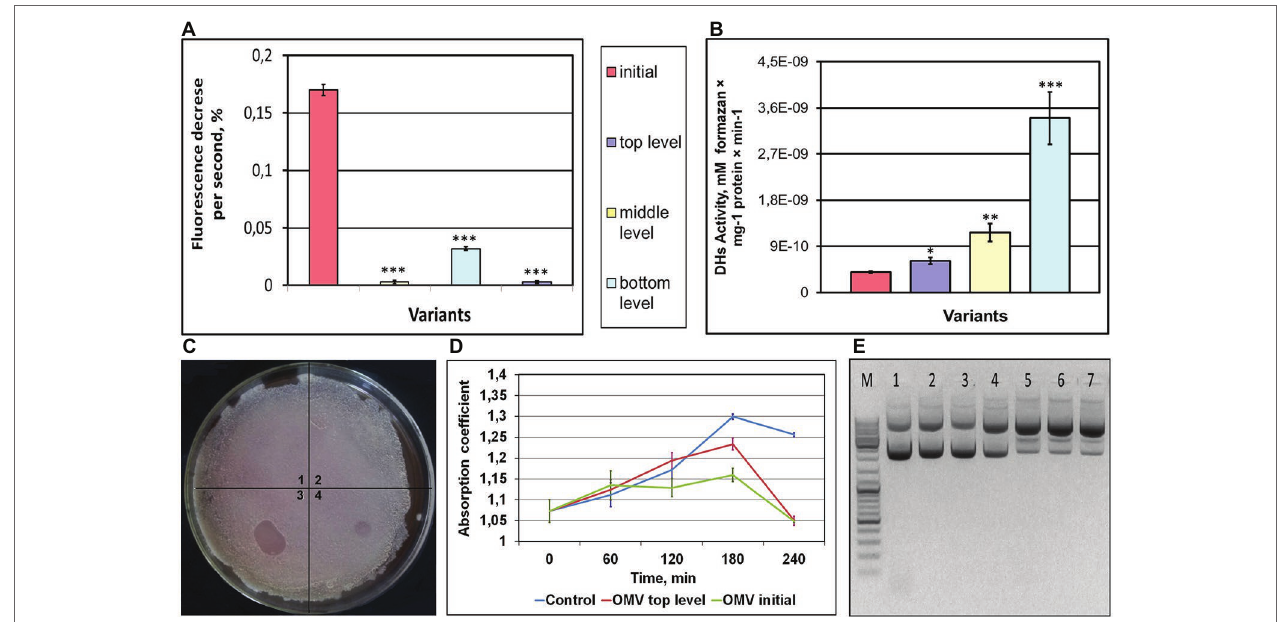
FIGURE 3 | Functionality of OMVs of K. intermedius , isolated from post-flight KMCs (A,B,D,E) and extracellular vesicles (EVs) isolated from the post-flight KMC samples (C) . (A) OMVs acidification measured using a pH-sensitive fluorescent dye acridine orange. Typical recording of acidification of OMVs from K. intermedius isolated from initial KMC and KMCs located at the top, middle, and bottom levels of a carrier mounted outside the ISS. (B) Dehydrogenase activity of OMVs of K. intermedius re-isolated from different KMCs. Data were shown as mean ± SD ( n = 3), * p ≤ 0.05; ** p ≤ 0.01; *** p ≤ 0.001. (C) The image of Bacillus subtilis lawn spotted with EVs. Clear zones are seen in spots of EVs from initial KMC (4) and EVs from bottom-located KMC (2). No visible changes seen after spotting with EVs of top- (1) and middle-located KMC (3). (D) Inhibitory activity of OMVs from K. intermedius in regard to B. subtilis . (E) Electrophoregram of plasmid pTZ19R after incubation with OMVs of K. intermedius . M–DNA ladder (ThermoFisher Scientific GeneRuler DNA Ladder Mix). 1 – control DNA (without incubation); 2 – control DNA (incubation, 37 °С ); 3 – control DNA (+PBS, incubation, 37 °С ); 4 – OMVs of K. intermedius from initial KMC; 5–7 – OMVs of K. intermedius from bottom-, middle-, and top-located KMCs, incubated with DNA at 37 °С